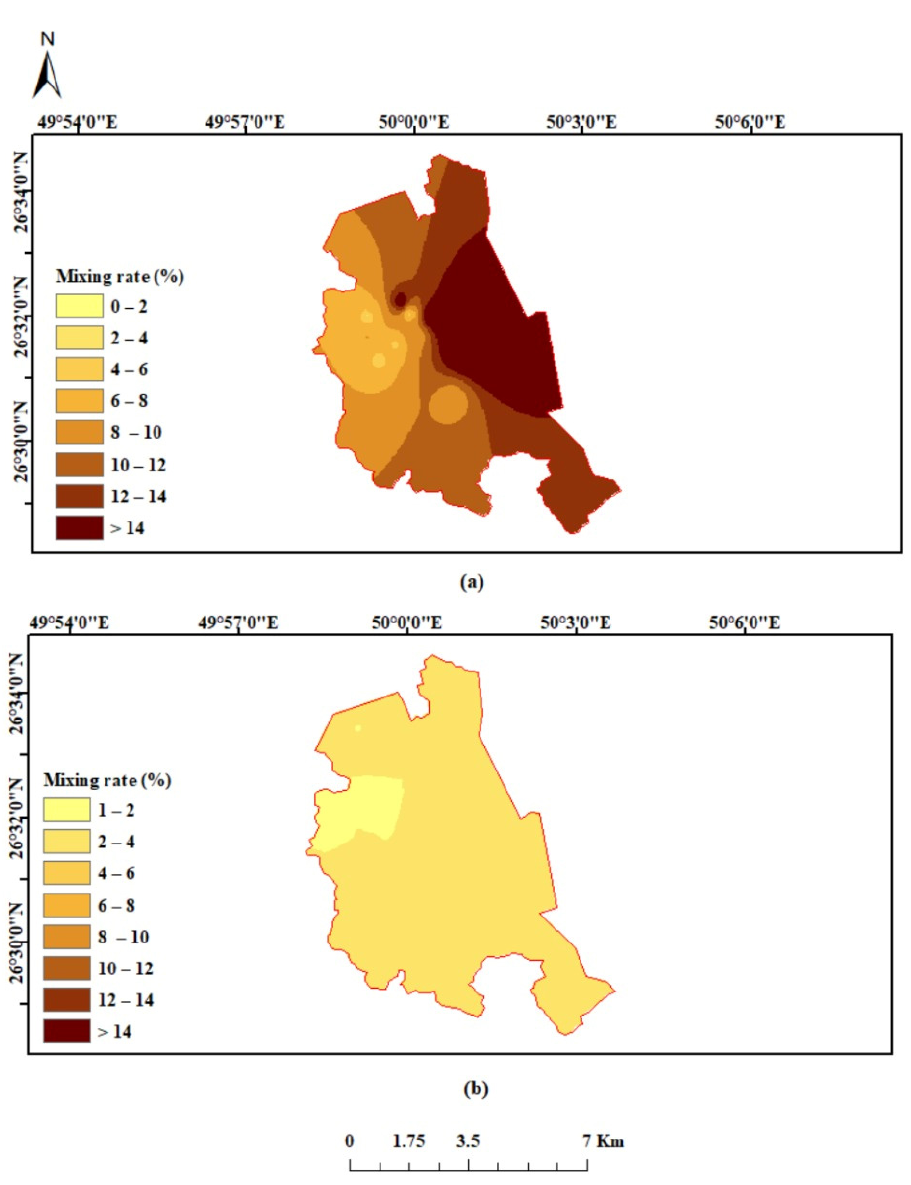
Figure 15. Spatial distribution map of seawater fraction of ( a ) shallow GW and ( b ) deep GW sam- ples.